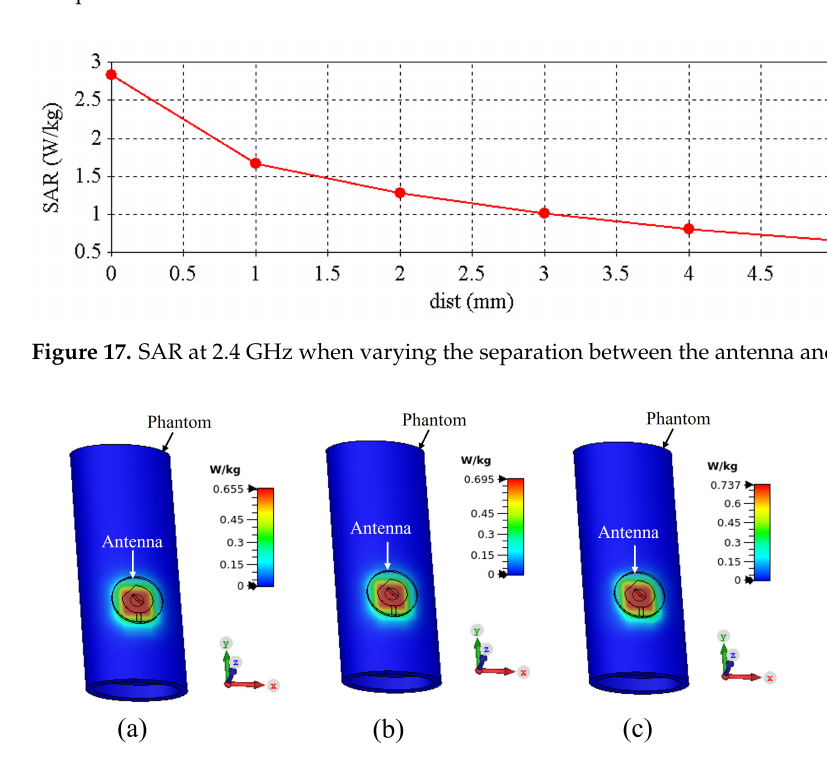
Figure 16. Radiation efficiency vs. frequency when varying the separation between the antenna and phantom.